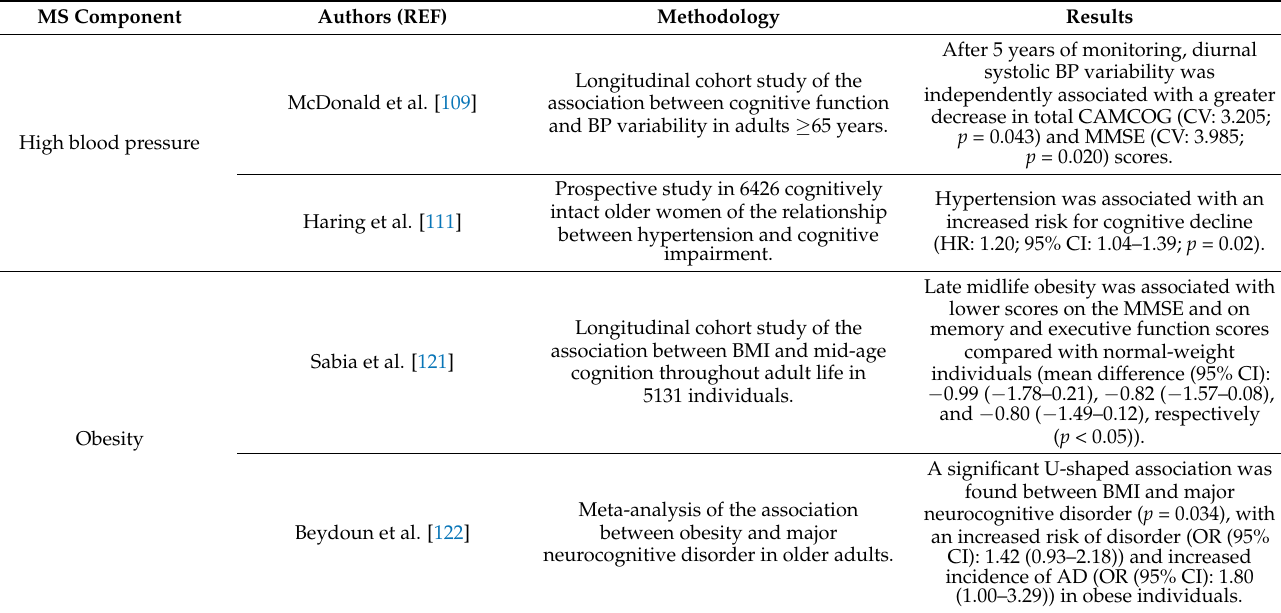
Table 1. Effects of components of MS on cognitive function, the risk of MCI, and major neurocognitive disorders. MS